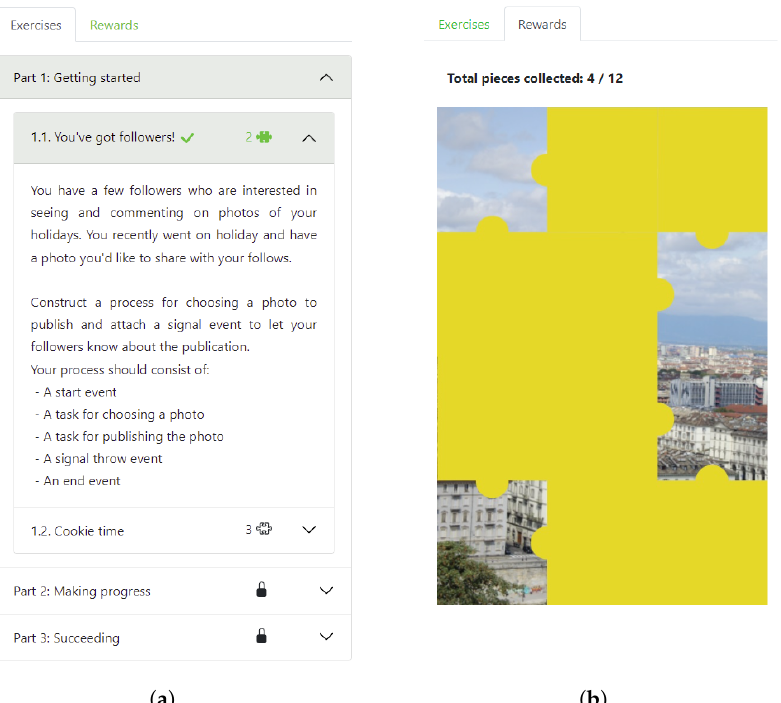
Figure 12. Rewards version main page—exercise list view and rewards tabs. ( a ) Exercise list. ( b ) Rewards